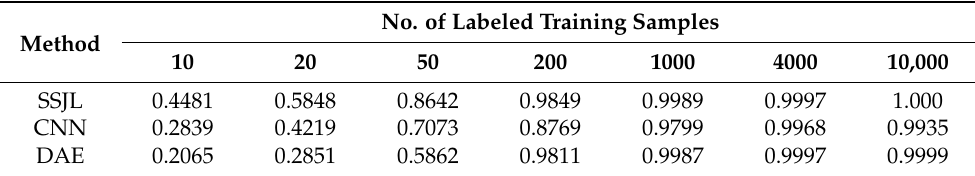
Table 5. Fault diagnosis accuracy of different methods on the CWRU dataset.